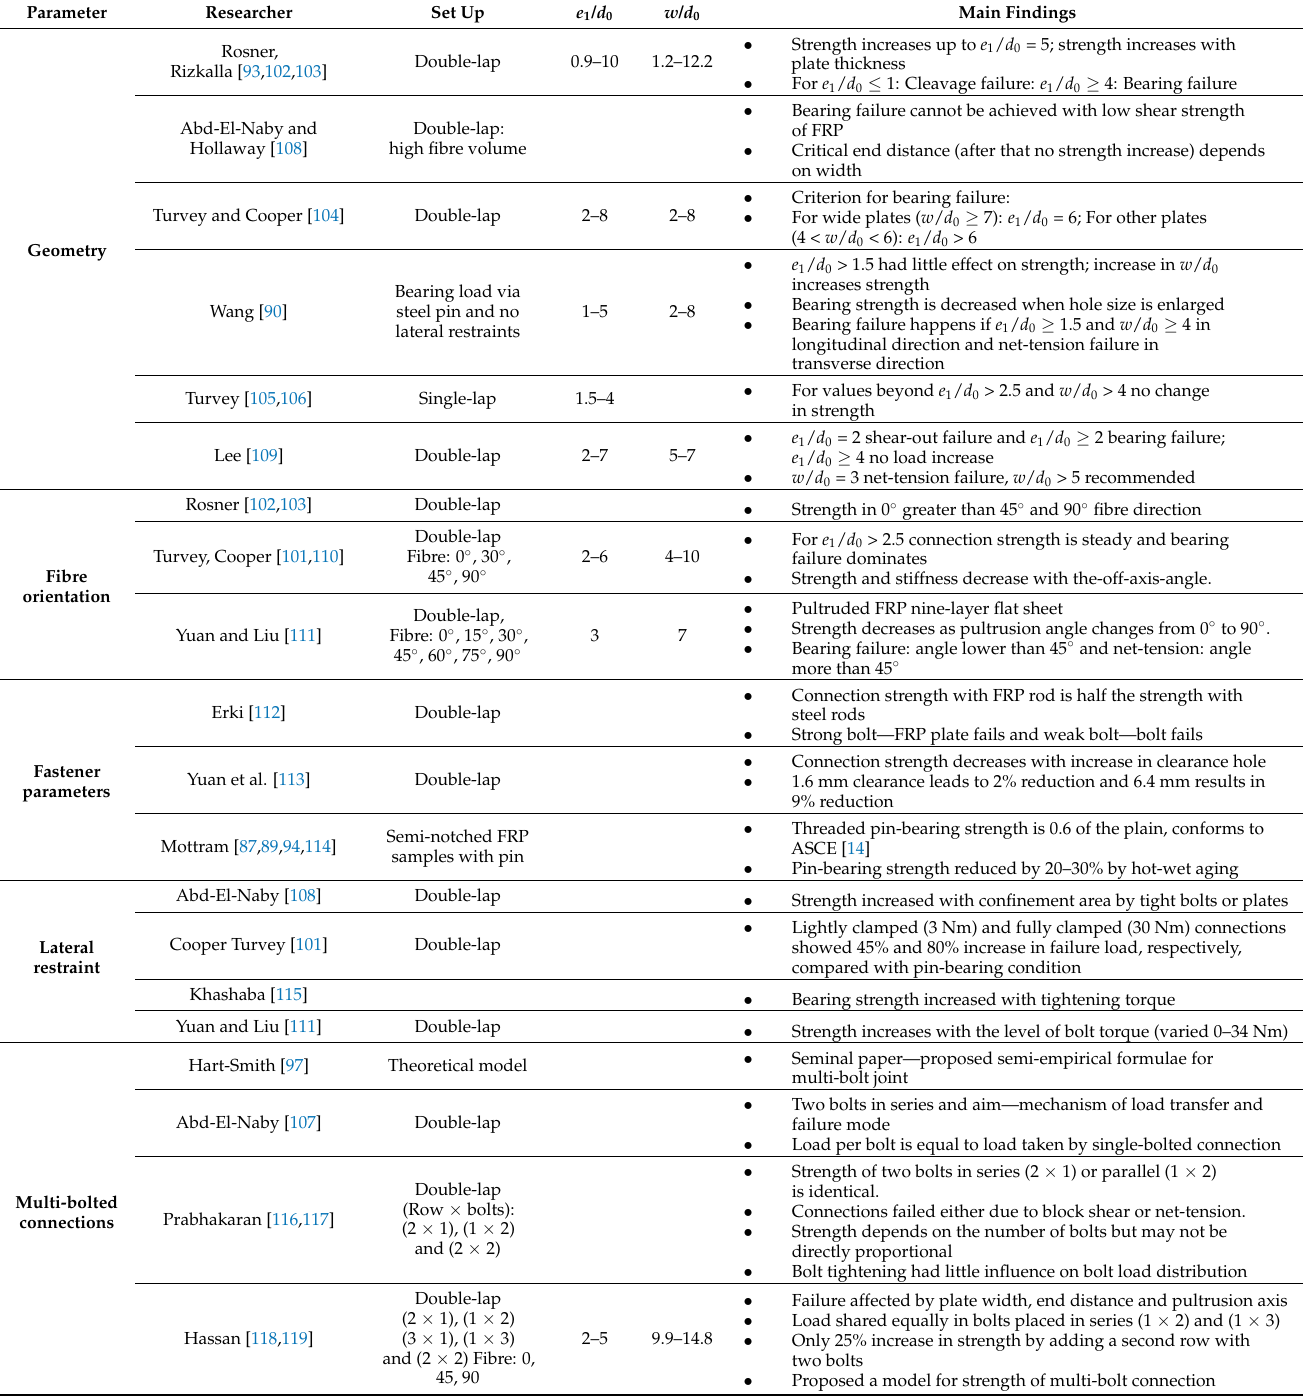
Table 5. Main findings and test parameters for FRP plate-to-plate